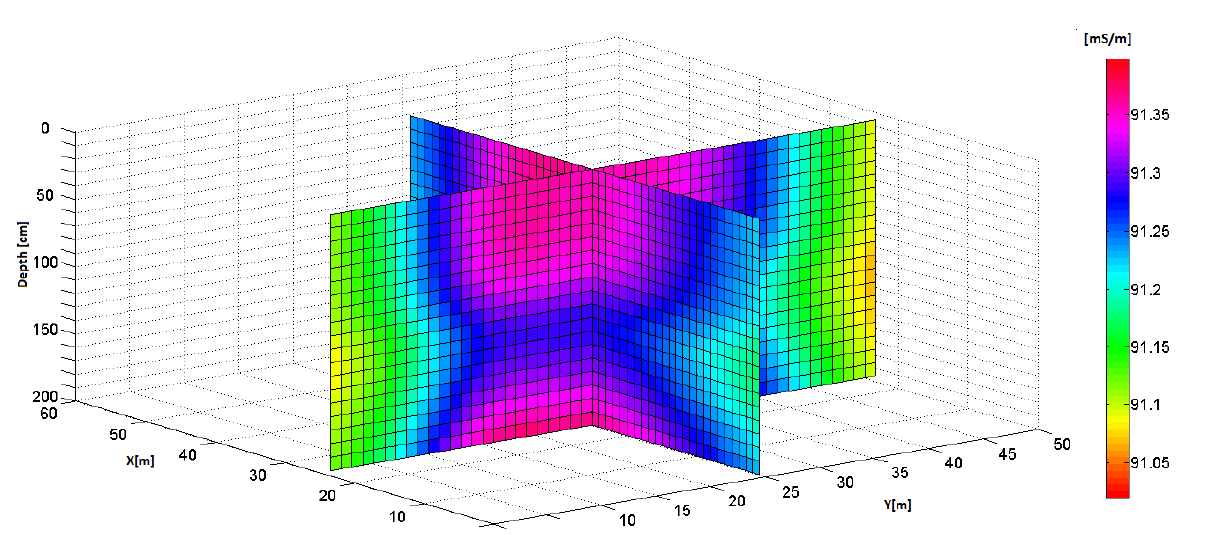
Figure 10. Electrical conductivity section in clay soil textures.